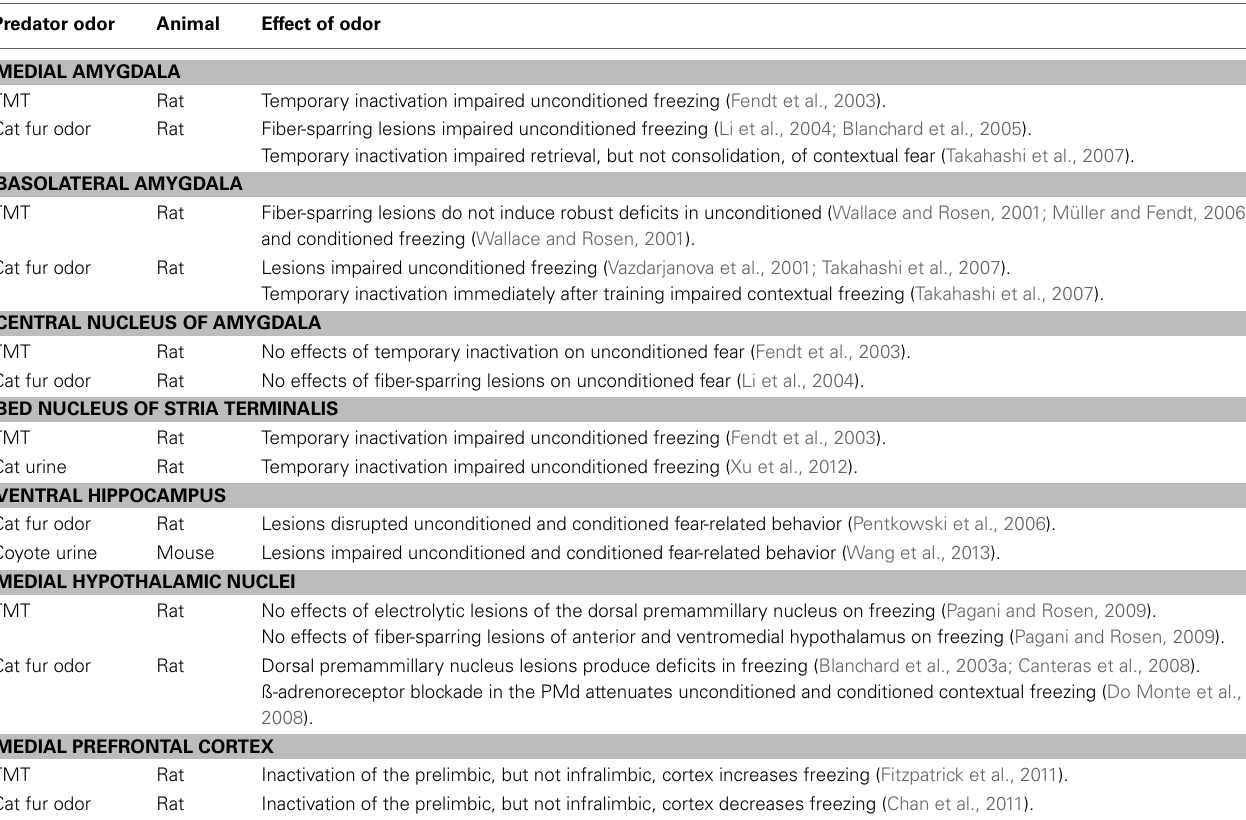
Table 3 | Brain structures that modulate predator odor unconditioned and conditioned fear. Predator odor Animal Effect of